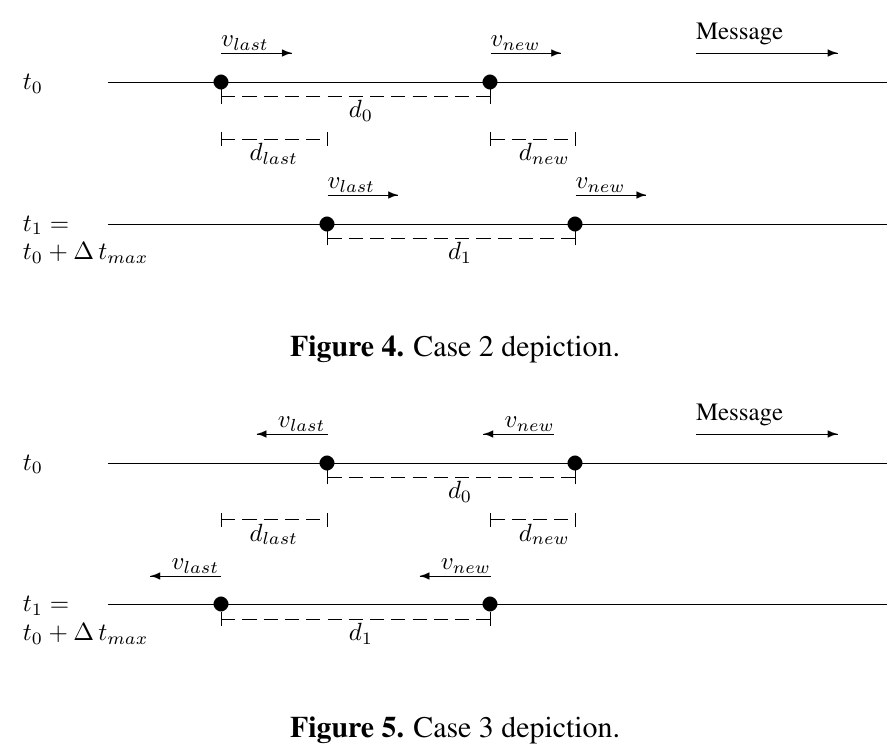
Figure 3. Case 1 depiction.